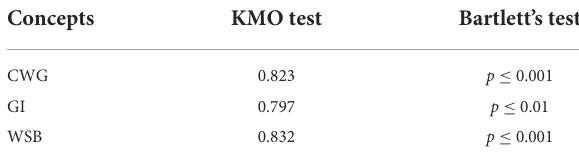
TABLE 2 Reliability analysis of the observed data. TABLE 3 KMO and Bartlett’s test results of CWG, GI and WSB.